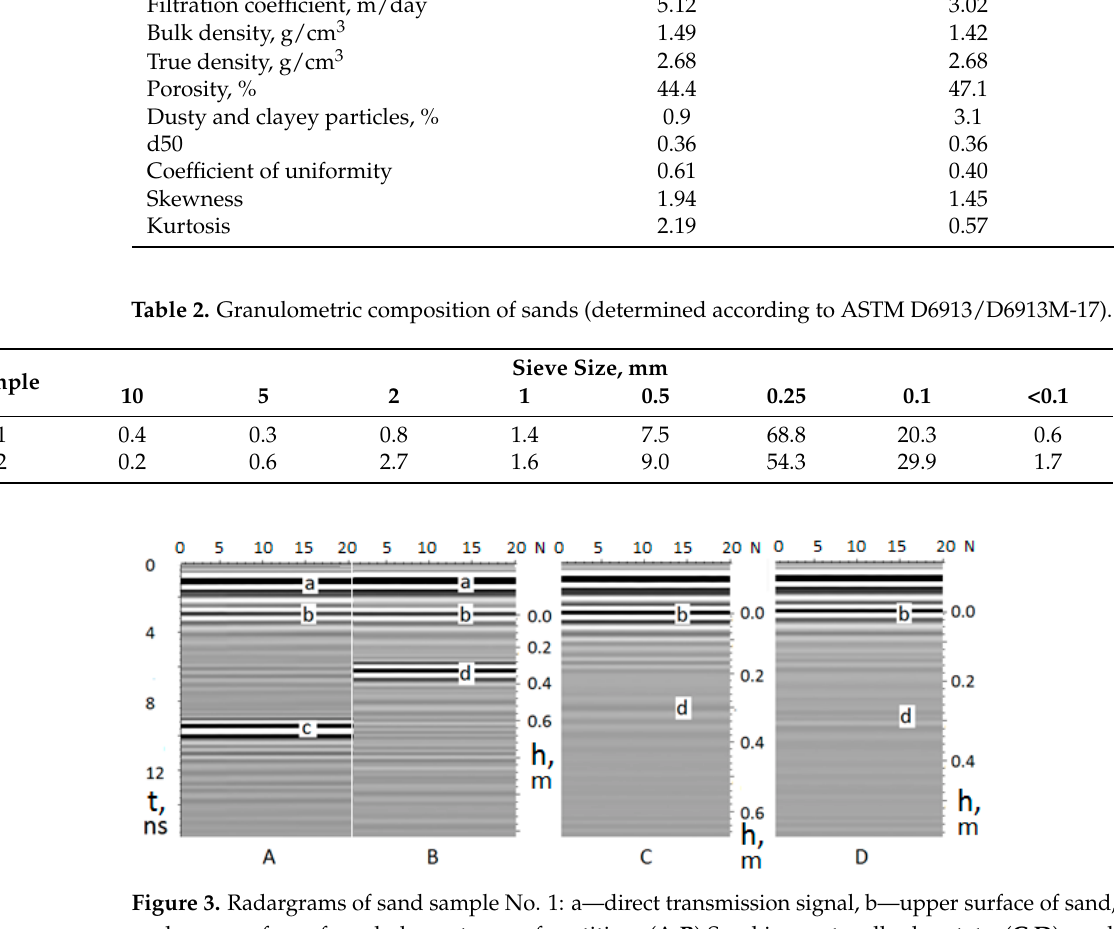
Table 3. Experimental conditions. Experiment (N)